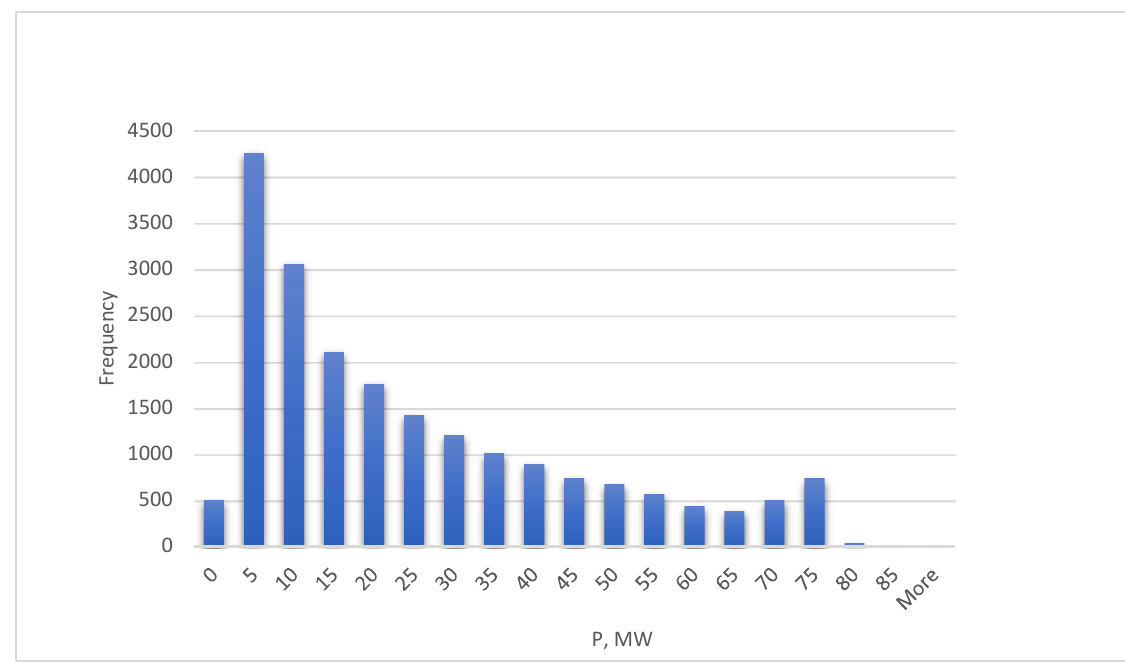
Figure 10. Histogram of the data collected between 2014 and 2017.